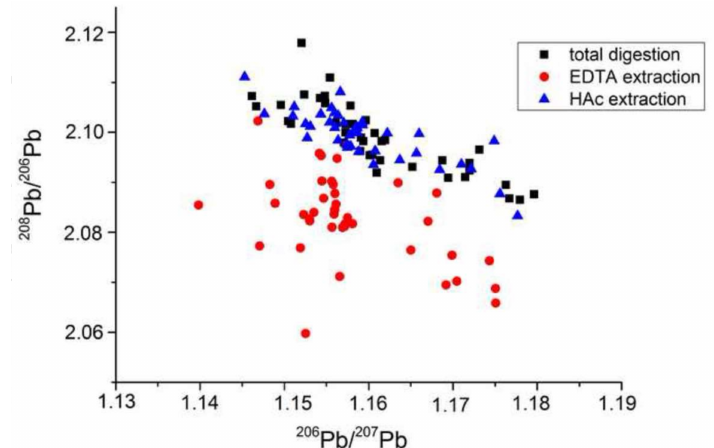
Figure 2. Isotopic compositions in digests and extracts from urban soils of Athens showing the scatter of data for the EDTA extractions probably arising from matrix effects during inductively coupled plasma-mass spectrometry (Q-ICP-MS) analyses compared with the expected linear arrays for the total digestions and HAc extractions. (From